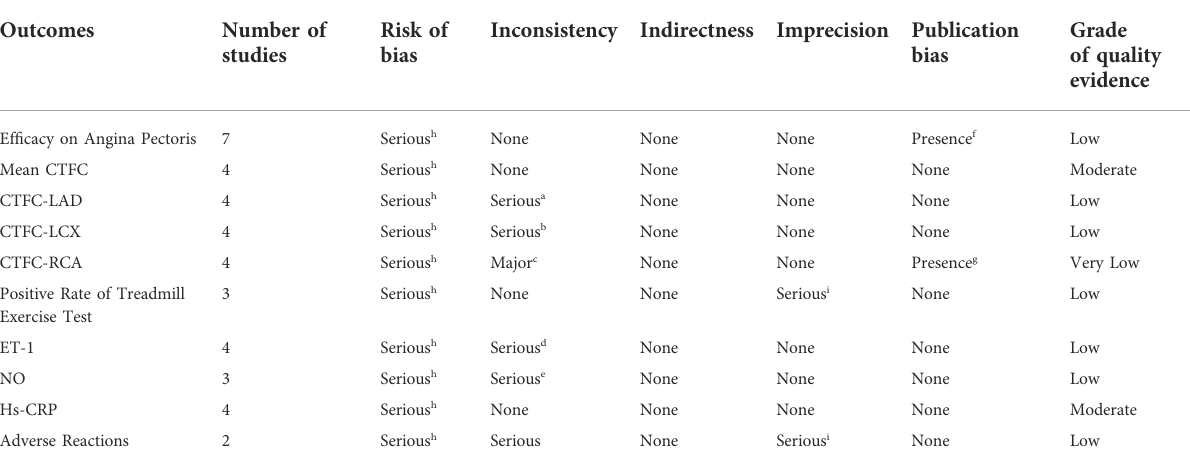
TABLE 4 GRADE evidence